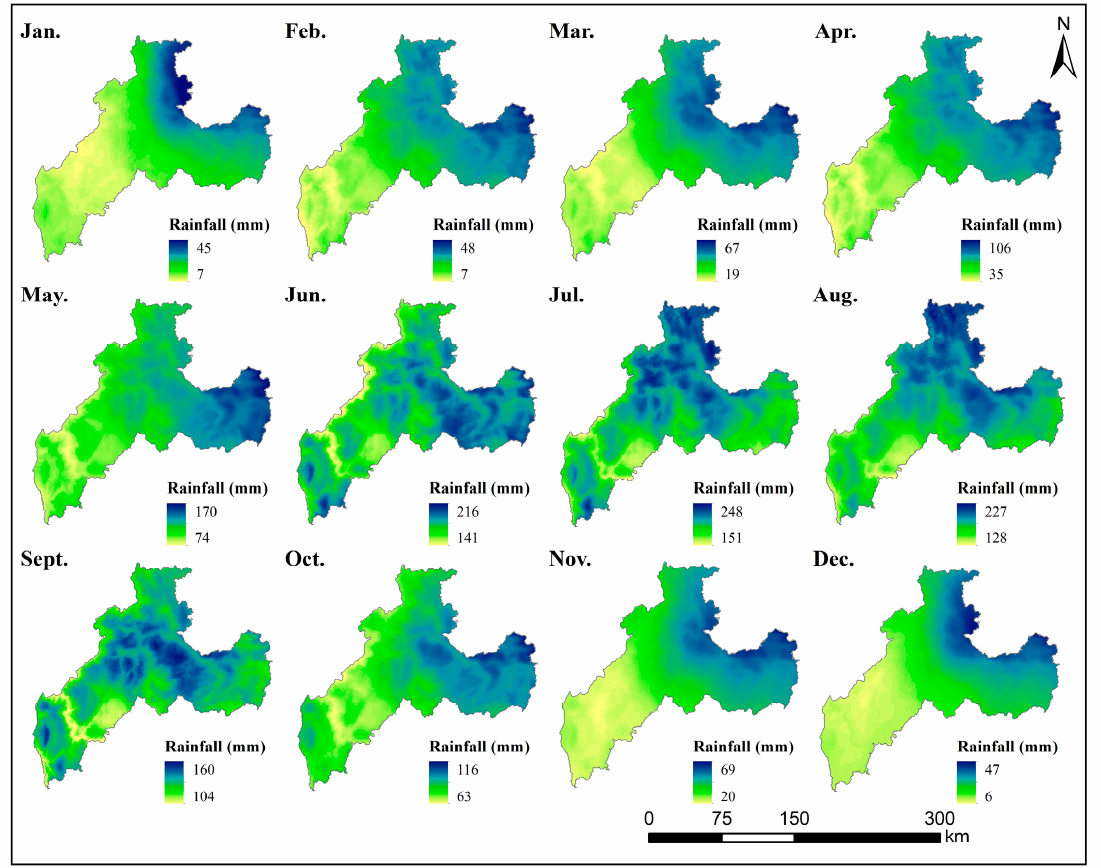
Figure 6. Average monthly rainfall distribution in Zhaotong from 2000 to 2020.